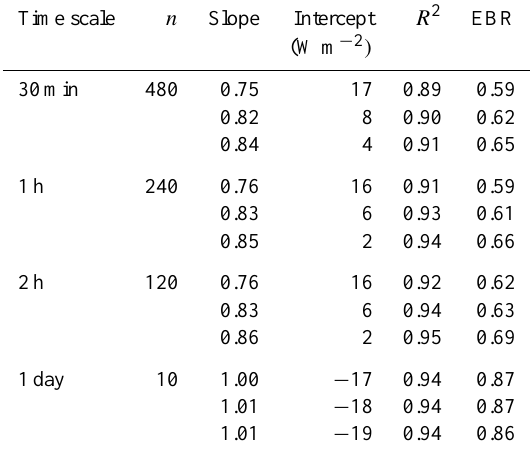
Table 4. Parameters of the linear regression between the turbulent flux ( H+LE ) and the available energy, as well as the Energy Balance Ratio (EBR), at different time scales. For each time scale the avail- able energy considered is: R n -G’ (top line), R n -G (middle line), and R n -G-S (bottom line). (S election of 10 days